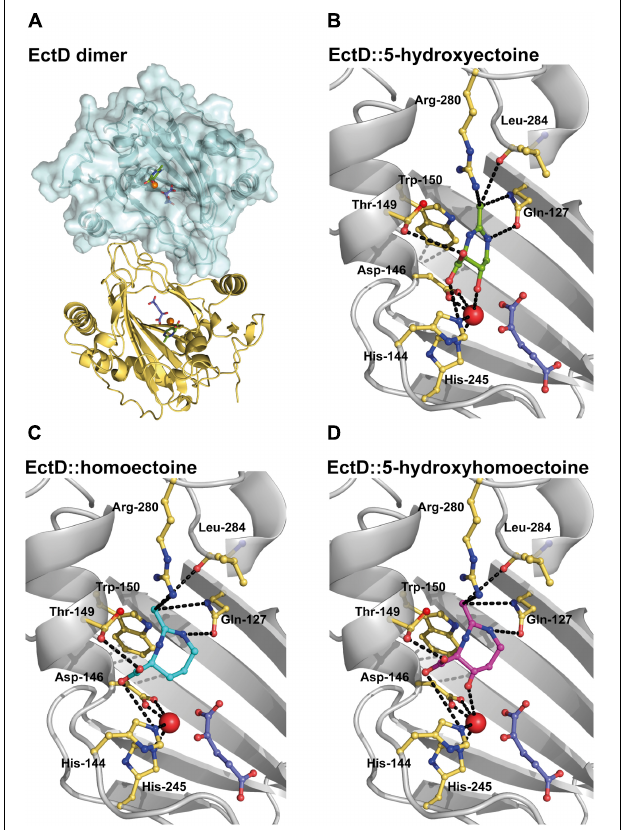
FIGURE 2 | Modeling and docking of different substrates into the crystal structure of the ectoine hydroxylase EctD from S. alaskensis. (A) The overall fold of the ( Sa )EctD (PDB accession code: 4Q5O) is shown as a dimer with one monomer presented as the surface structure of the protein and the other monomer in cartoon representation. Each monomer harbors the product, 5-hydroxyectoine (green) of the ( Sa )EctD-catalyzed enzyme reaction, the co-substrate 2-oxoglutarate (light blue), and the catalytically important ion metal (red ball). Zoom into the active site of ( Sa )EctD with (B) the bound natural reaction product 5-hydroxyectoine (green), (C) the modeled synthetic substrate homoectoine (blue), and (D) the modeled synthetic reaction product 5-hydroxyhomoectoine (pink). The amino acids involved in substrate binding are shown as yellow sticks and possible interactions are indicated by black dotted